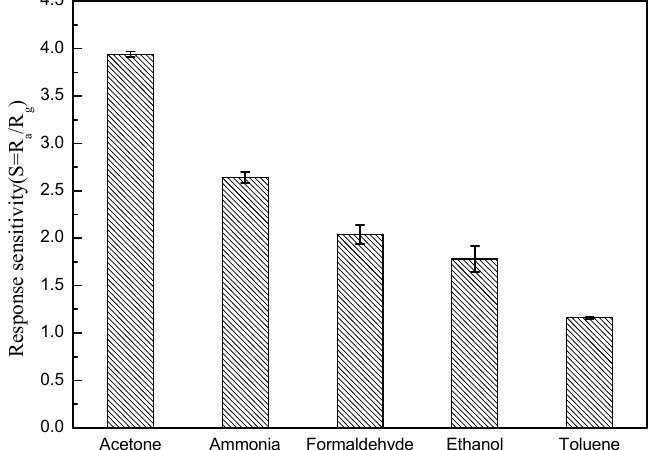
Figure 8. Cross-responses of the SnO 2 /ZnO sensor to acetone, ammonia, formaldehyde, ethanol, and toluene, each at 10 ppm concentration.